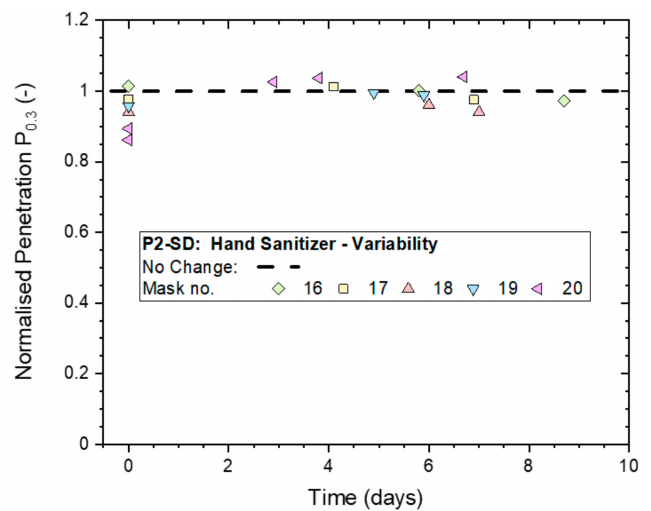
Figure 8. Variation in the normalized penetration P n0.3 from whole-mask screening tests between five masks (P2-SD: Shanghai Da Sheng) after exposure to continuous hand sanitizing actions for 4 h and subsequent storage in plastic bags for up to 9